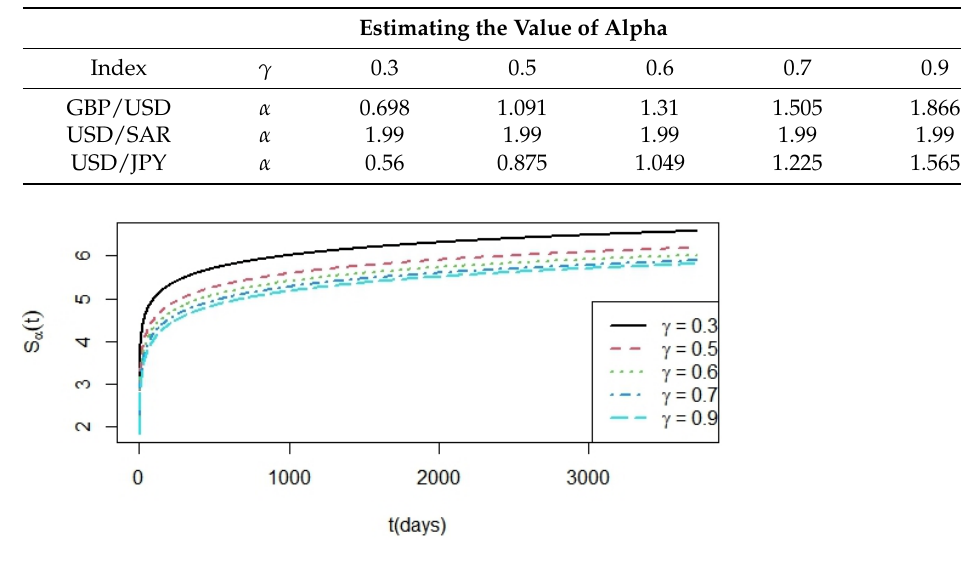
Figure 6. The entropy analysis of (34) for the TASI, where α = 0.299, 0.452, 0.535, 0.62, and 0.796 from Table 1, the monotonic increase of α for increasing γ is accompanied by the monotonic decrease of S ( P , t ) for increasing, demonstrating the regime’s α ordering. Table 2. Estimating the value of α at various γ values in the range ( 0,1 ) while fitting to GBP/USD, USD/SAR, and USD/JYP real market exchange rates from 2000 to 2022.